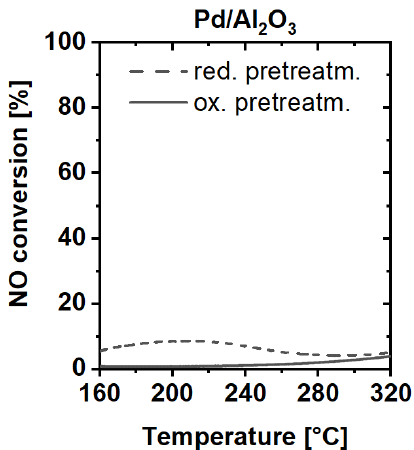
Figure A5. Catalytic activity for NO conversion after reductive and oxidative pretreatment of Pd/Al 2 O 3 (fresh state) during a light-off test in 800 ppm NO, 7% CO 2 , 5% O 2 , 5% H 2 O, and bal. N 2 at a GHSV of 40,000 h − 1 .